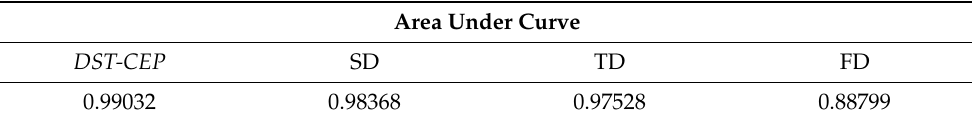
Figure 11. ROC curves analyzed. ( a ) ROC curves of detectors and DST-CEP ; ( b ) ROC curves of temperature detector and DST-CEP ; ( c ) ROC curves of flame detector and DST-CEP ; and ( d ) ROC curves of smoke detector and DST-CEP . Table 5. AUC